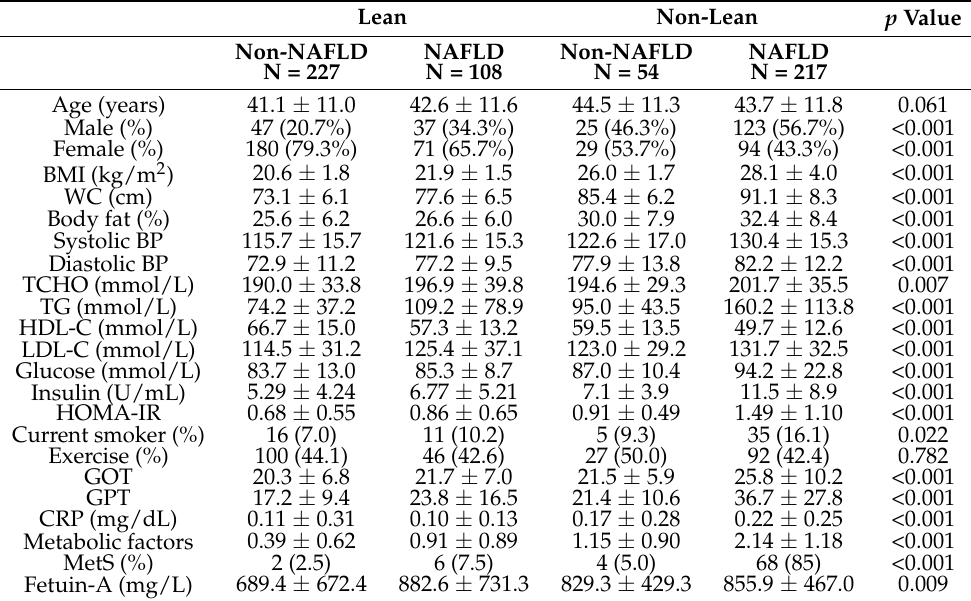
Table 1. Baseline characteristics among the lean, non-lean, NAFLD, and non-NAFLD groups. Lean Non-Lean p Value